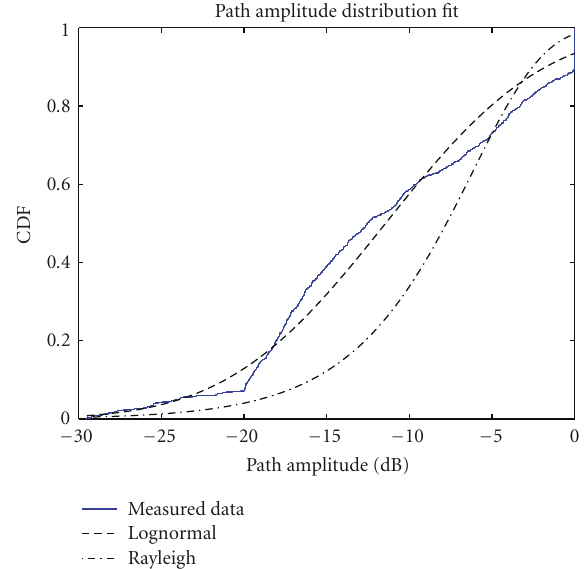
Figure 14: Path amplitudes CDF with the best-fit Rayleigh (RMSE = 1.1789) and lognormal (RMSE = 0.0489) distributions for measurements beneath the Taurus chassis.